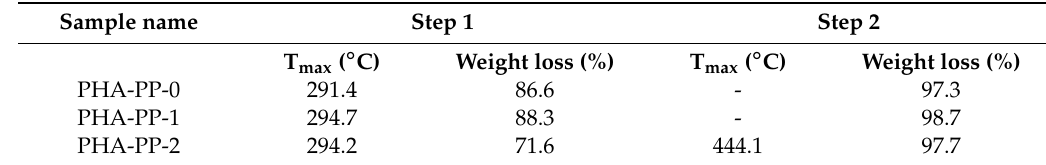
Table 5. Thermogravimetric parameters for PHA samples produced after 48 h shake flask procedures with PP samples utilized as additional carbon sources in TSB media.